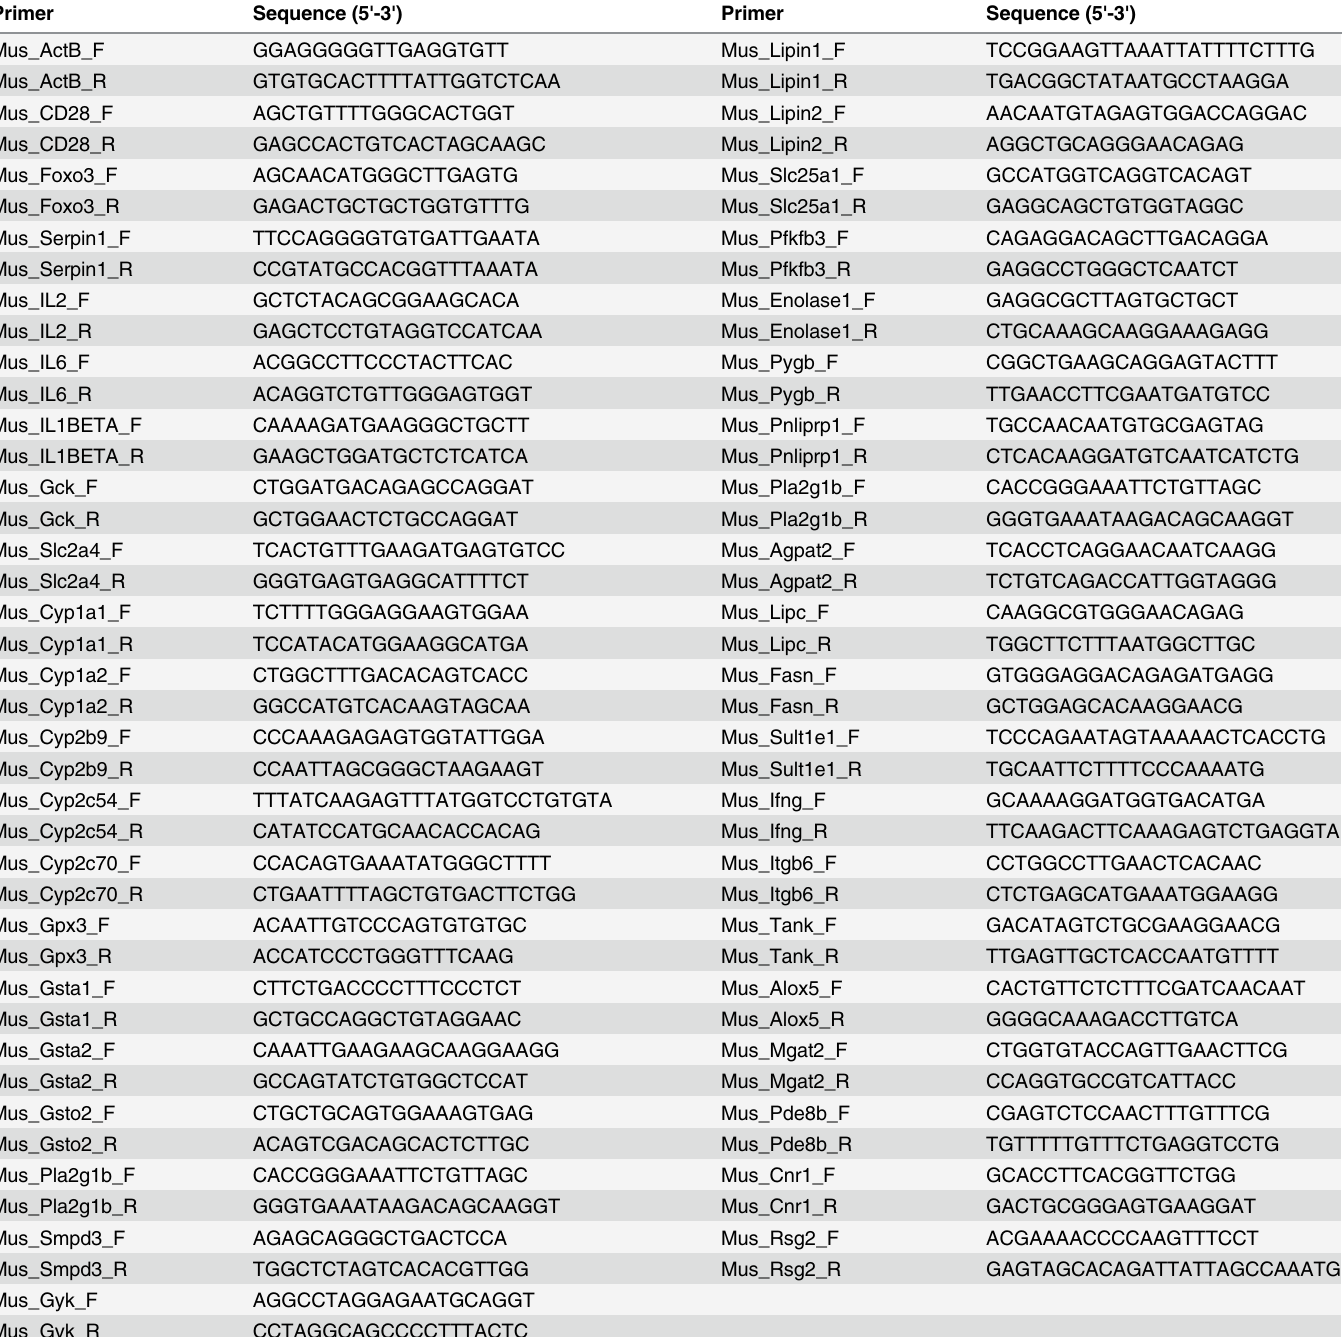
Table 1. Primers used for real-time qRT-PCR experiments.